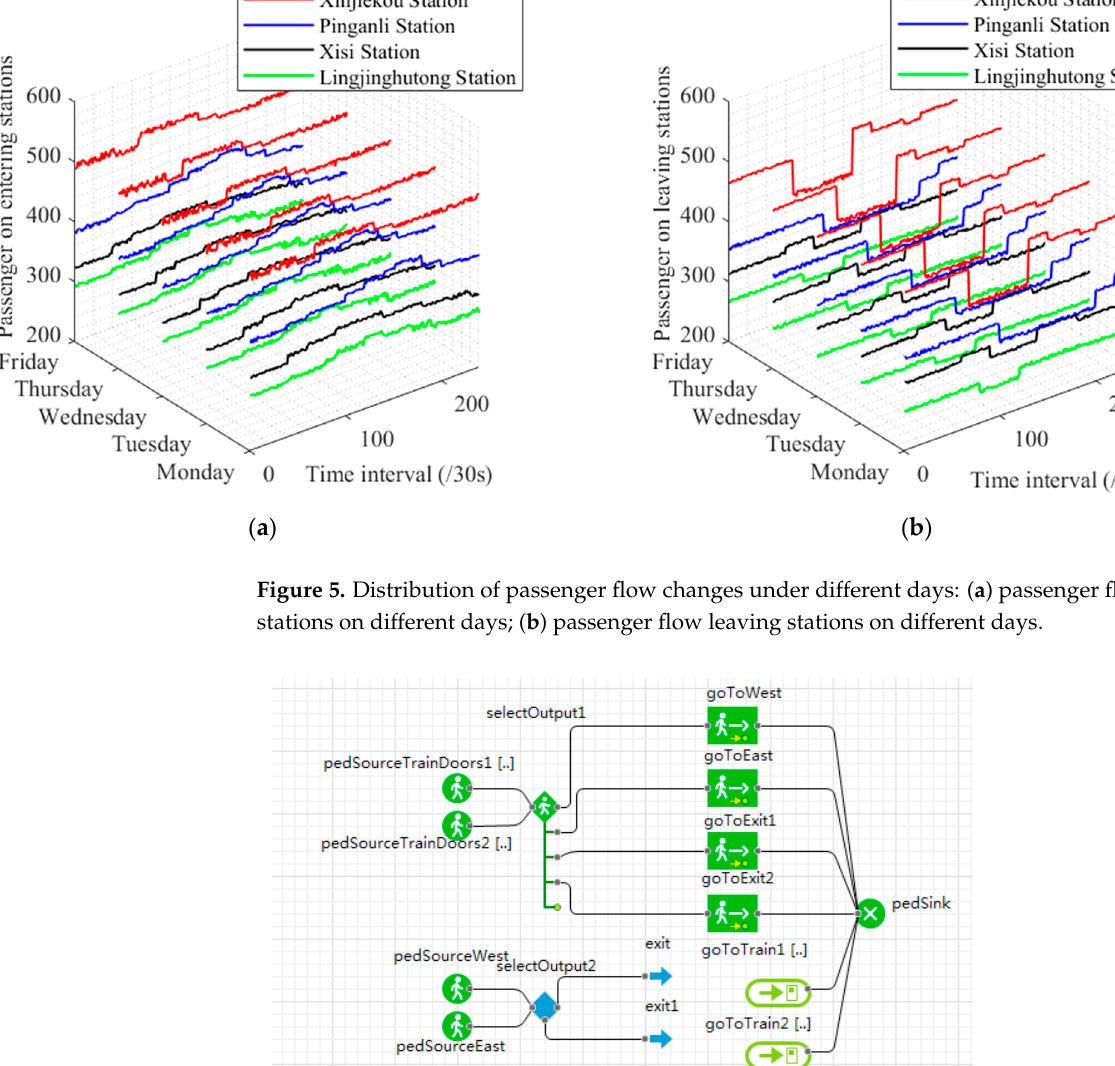
Figure 6. Simulation modeling of passenger activity.